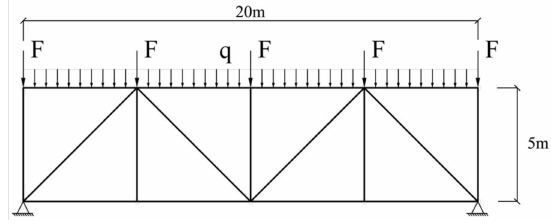
Figure 12. Initial layout of the truss structure. Table 7. Design parameters.